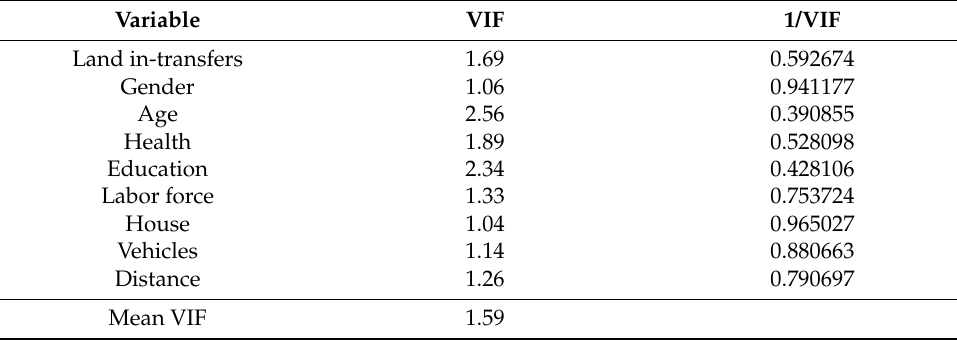
Table 3. Results of the multicollinearity of the independent